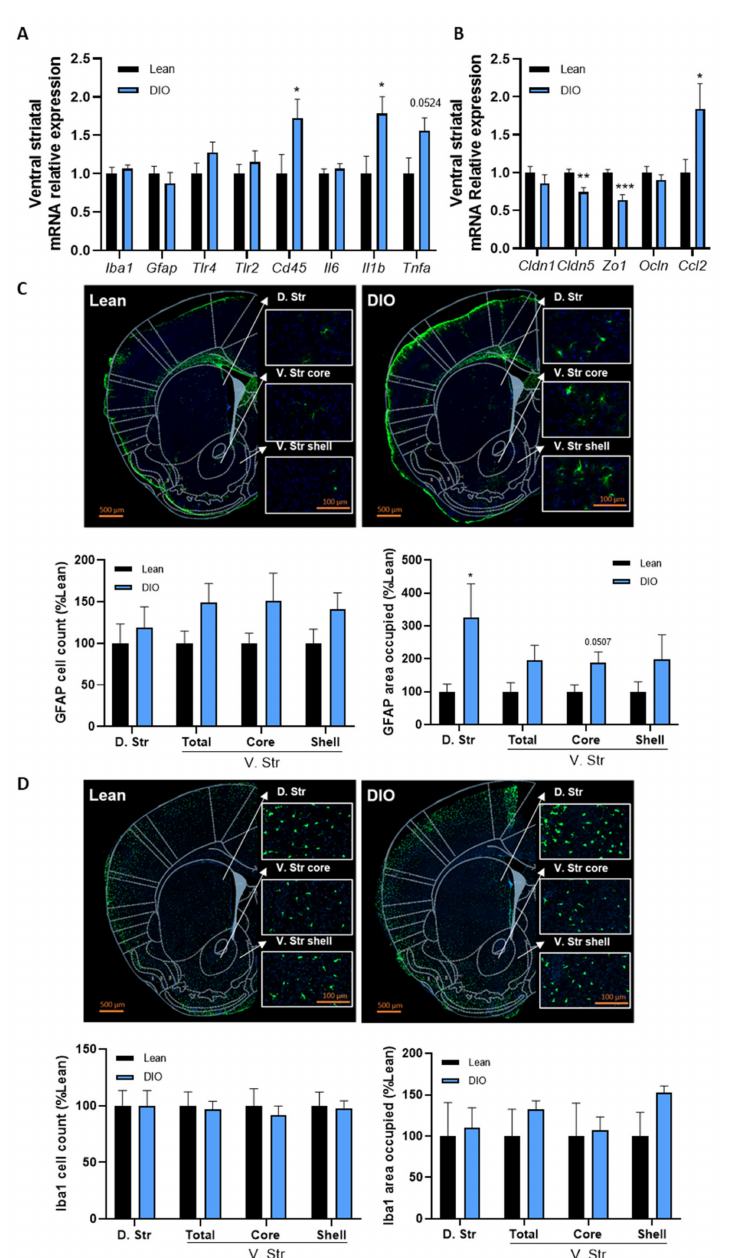
Figure 2. Obesity is associated with inflammation and blood–brain barrier alterations in the stria- tum. ( A ) Ventral striatal mRNA relative expression of ionized calcium-binding adapter ( Iba1 ), glial fibrillary acidic protein ( Gfap ), toll-like receptor 4 ( Tlr4 ), toll-like receptor 2 ( Tlr2 ) cluster of differen- ciation 45 ( Cd45 ), interleukin 6 ( Il6 ), interleukin 1 beta ( Il1b ) and tumor necrosis factor alpha ( Tnfa ) and ( B ) claudin–1 ( Cldn1 ), claudin–5 ( Cldn5 ), zonula occludens 1 ( Zo1 ), occludin ( Ocln ) and C-C chemokine ligand 2 ( Ccl2 ) measured by real-time qPCR in lean and DIO mice. ( n = 9–10/group). ( C ) Representative immunofluorescence of the dorsal striatum (D. Str), the ventral striatum (V. Str) total, core and shell and quantification of both the area occupied by astrocytes cells and the GFAP+ cells in these regions of lean and DIO mice ( n = 4–5/group). ( D ) Representative immunofluorescence of the dorsal striatum (D. Str), the ventral striatum (V. Str) total, core and shell and quantification of both the area occupied by microglial cells and the Iba1+ cells in these regions of lean and DIO mice ( n = 5/group). Data are shown as mean ± SEM. p -values were obtained after unpaired Student’s t -test or non-parametric Mann–Whitney test. *: p -value < 0.05; **: p -value < 0.01; ***: p -value < 0.001 between lean vs.